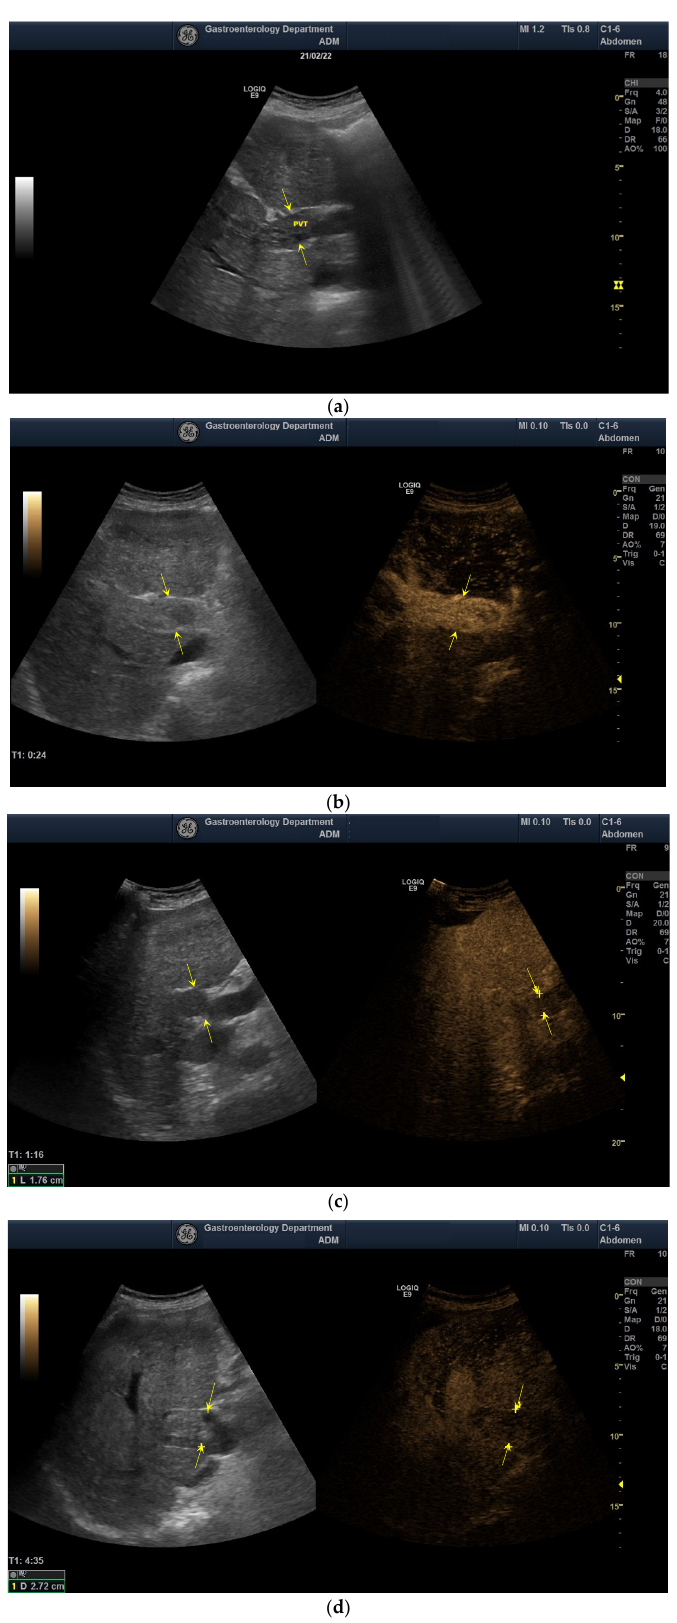
Figure 2. Ultrasound and CEUS aspect of TIV: ( a ) aspect in the standard US (between arrows), ( b ) hyperenhancement in the arterial phase (between arrows), ( c ) washout in the portal phase (between arrows), ( d ) washout in the late phase (between arrows).